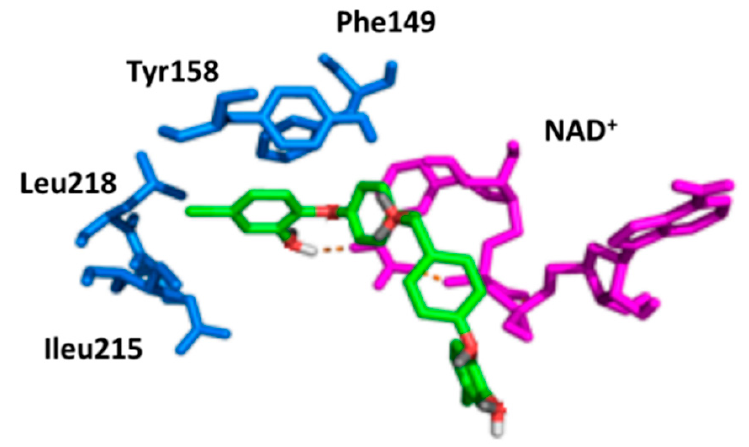
Figure 5. A view of the docking of 38 into the InhA active site. The active site residues (blue), NAD + (magenta) and ligand (green).